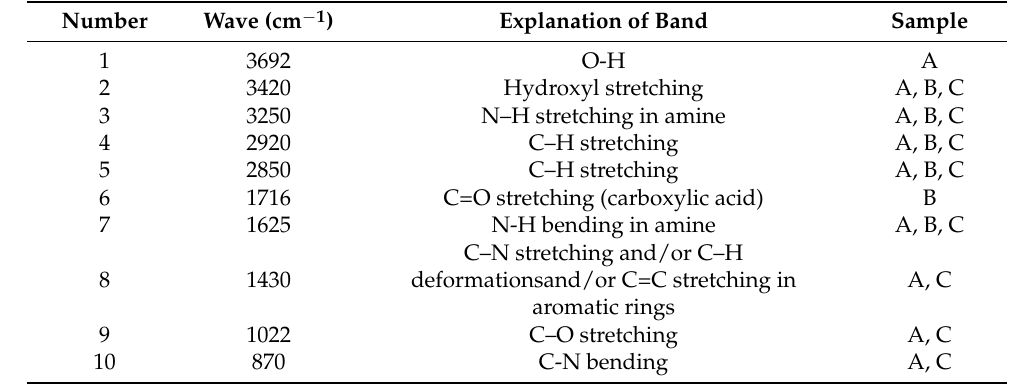
Table 1. Analysis for FT-IR spectra of